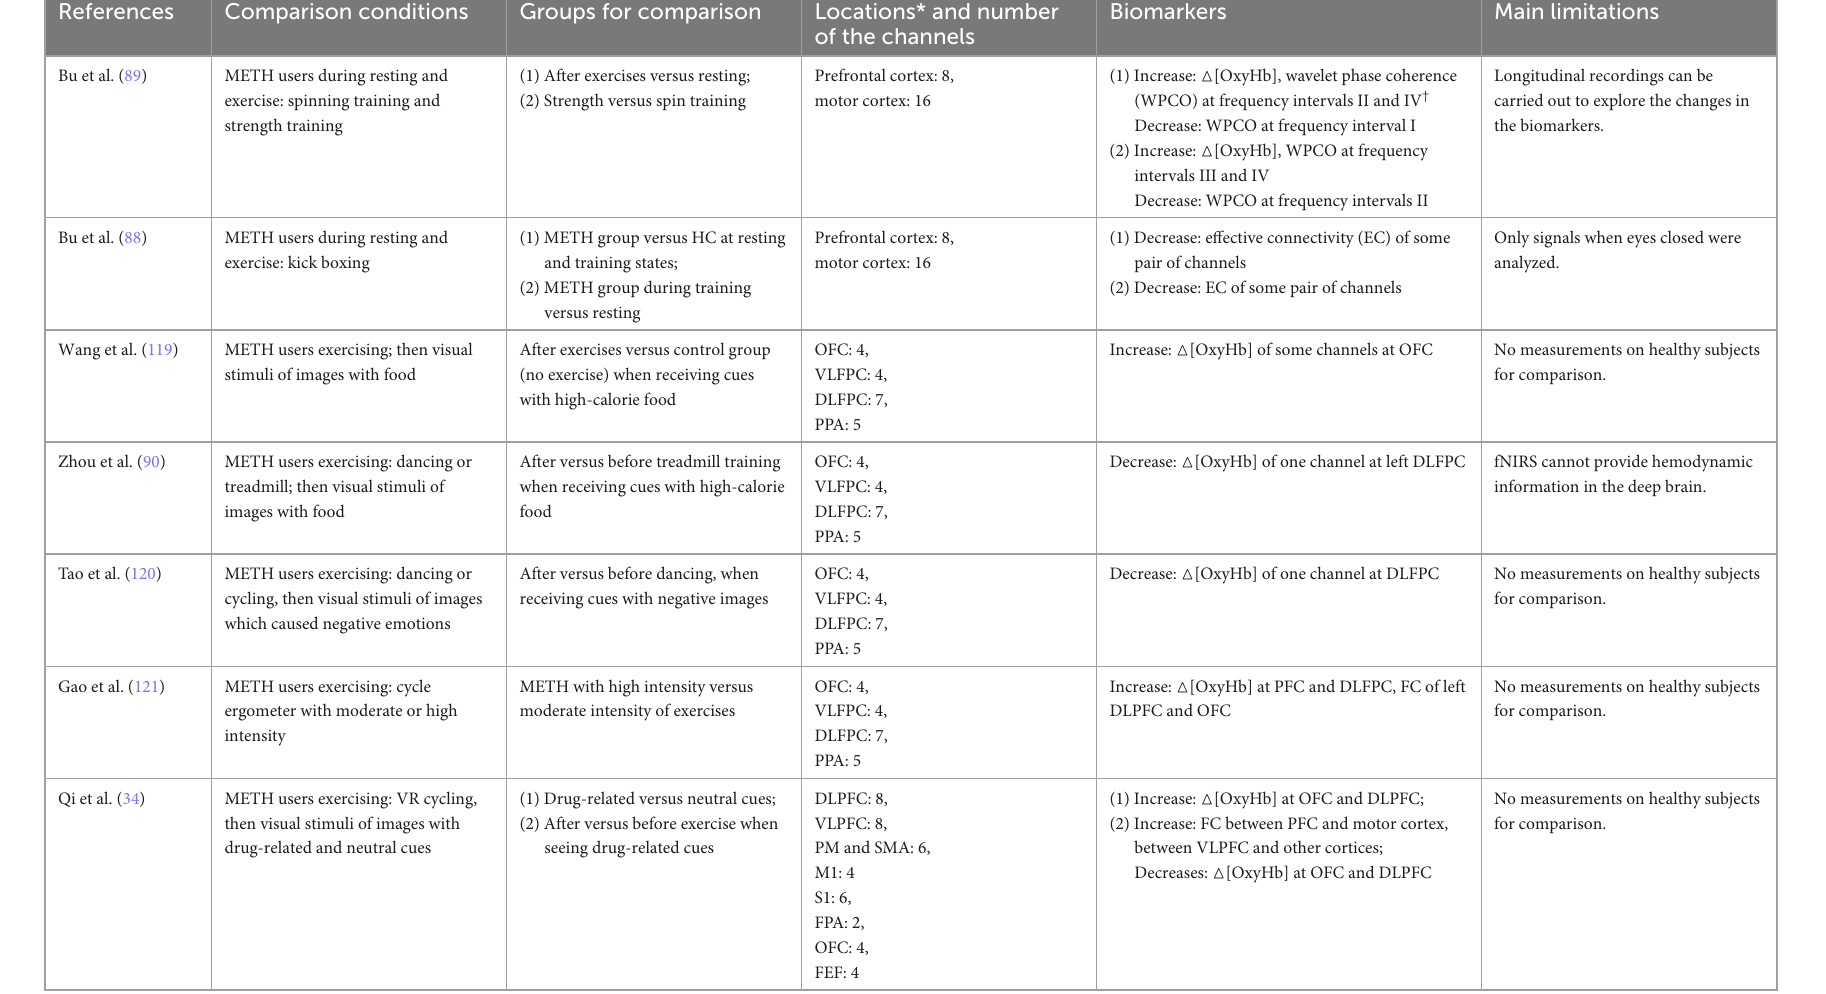
TABLE 3 Biomarkers of fNIRS signals recorded on patients with methamphetamine addiction. The biomarkers include variation of hemoglobin concentration and functional connectivity